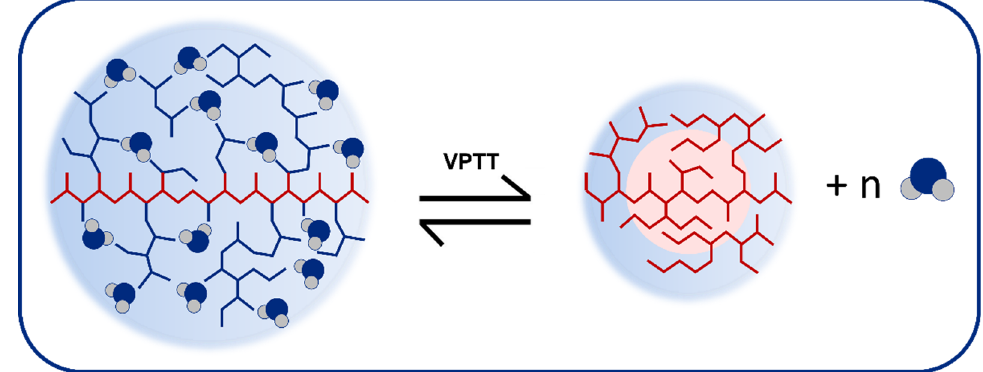
Figure 1. A schematic representation of the thermo-response of this type of polymeric